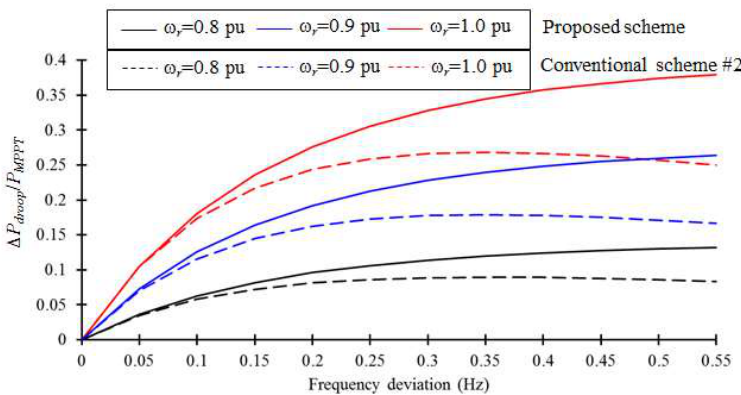
Figure 9. K sup for the proposed and conventional IRI schemes.